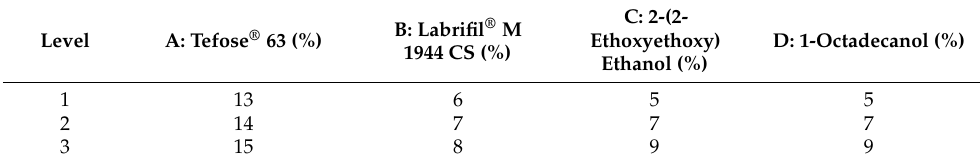
Table 2. Influencing factors and levels of cream formula (after optimization).